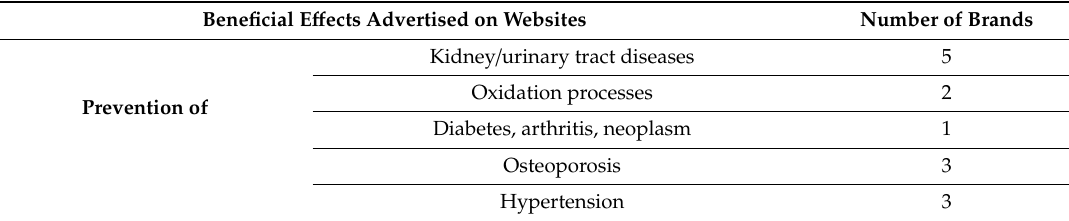
Table 2. Wording included in website of the selected bottled water ( n =